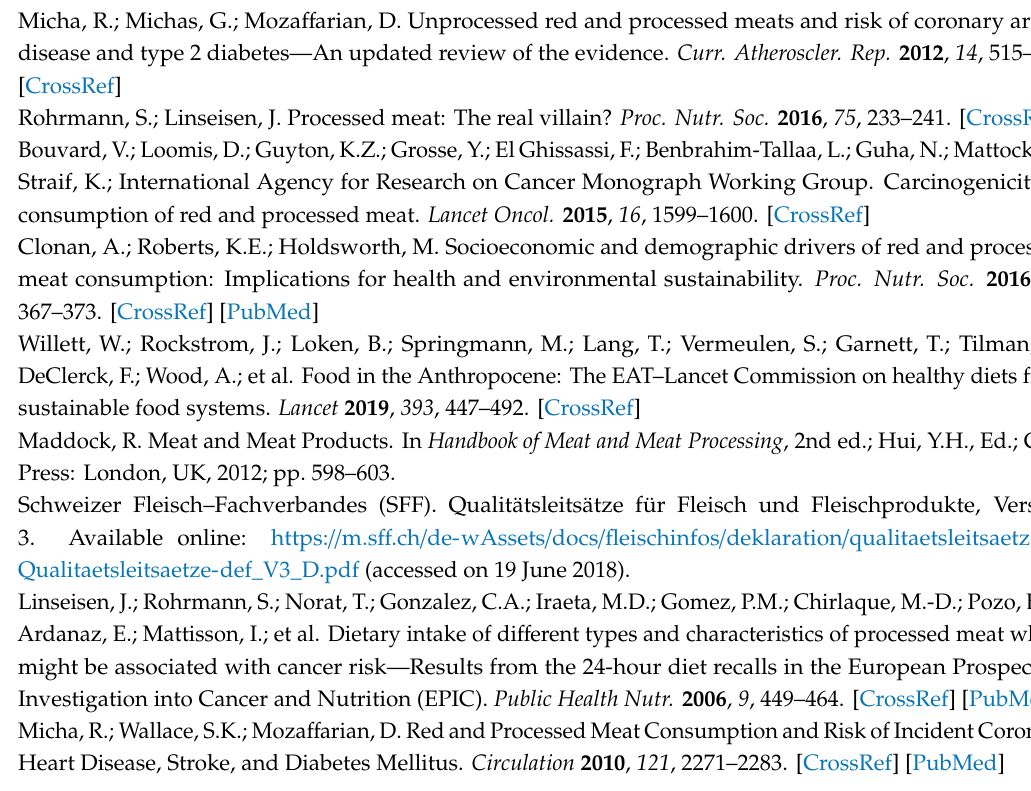
Figure S1: Categorization of processed meats, National Nutrition Survey menuCH, N = 2057, Figure S2: Histogram of processed meat intakes, National Nutrition Survey menuCH, N = 2057 (crude